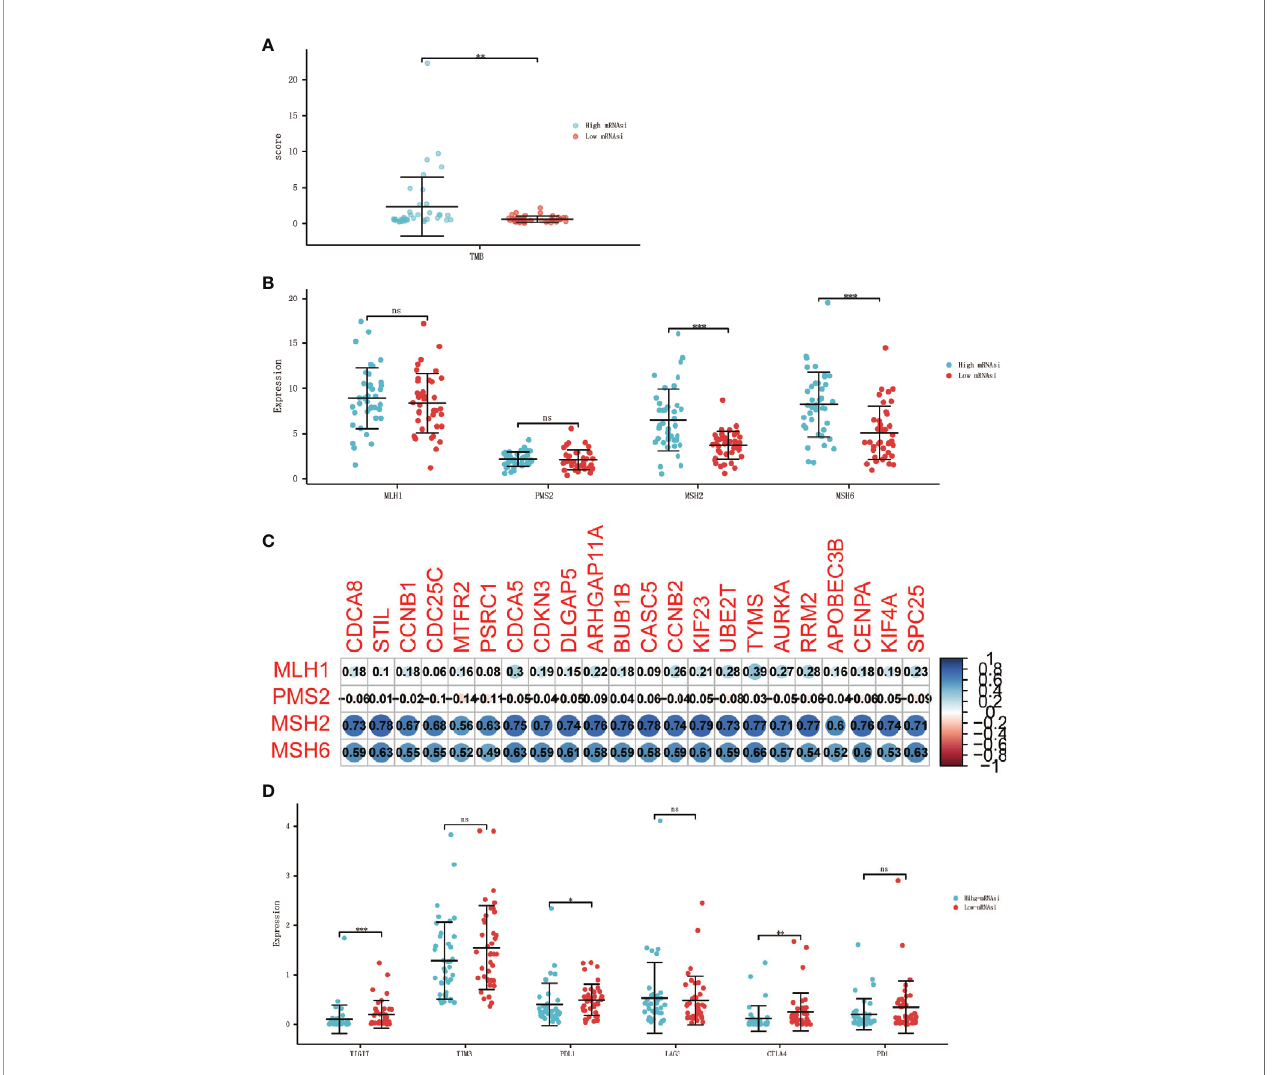
FIGURE 7 | Association between ICIs biomarkers and cancer stemness. (A) Differential analysis of the TMB between high-mRNAsi and low-mRNAsi groups. (B) Differential analysis of the expression of MMR-related genes between high-mRNAsi and low-mRNAsi groups. (C) Correlation analysis between MMR-related genes and 22 stemness-related hub genes. (D) Differential analysis of the expression of immune checkpoints between high-mRNAsi and low-mRNAsi groups (PD-1, PD- L1, CTLA-4, LAG-3, TIM3, and TIGIT) (*P < 0.05, **P < 0.01, ***P < 0.001, ns, not signi fi